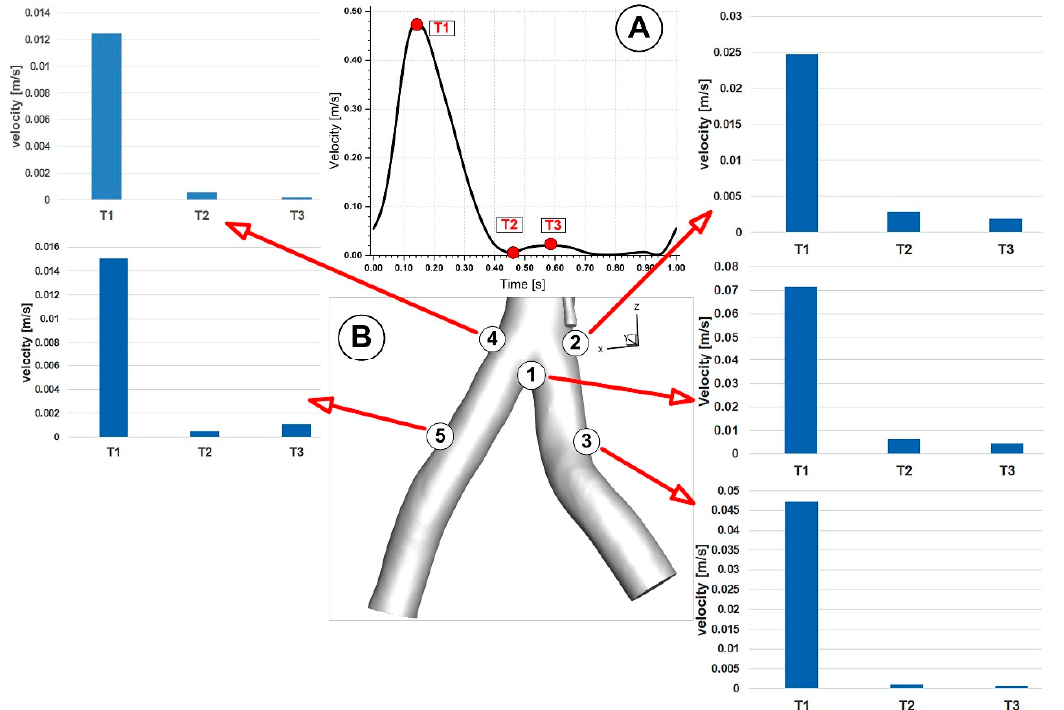
Figure 17. Velocity evolution at various locations along the iliac artery bifurcation ( B ) during different time steps (corresponding to time T1, T2, and T3, respectively ( A )).